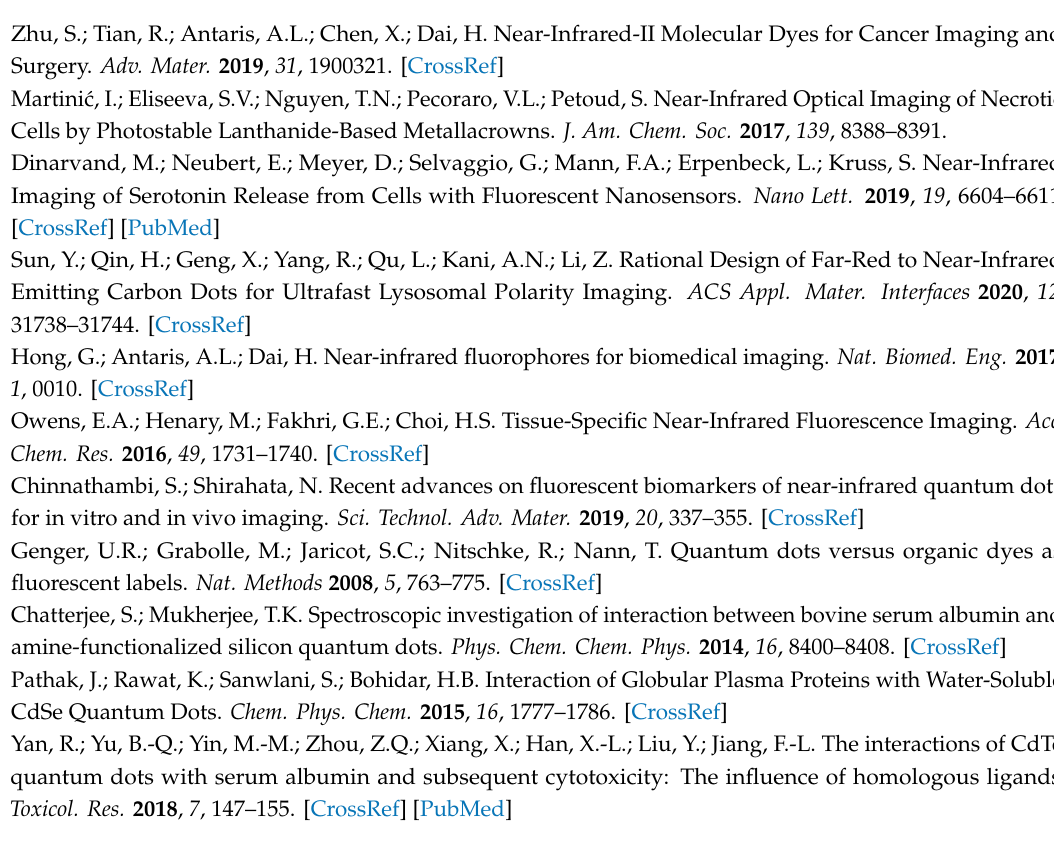
Figure S1: (a) A typical XRD spectrum of hydrogen-terminated SiQDs by HF etching for 85 min. (b) ATR-FTIR spectra of hydrogen-terminated SiQDs before and after hydrosilylation of 1-decence. Figure S2: Three di ff erent stages for preparing SiQD-De / F127 nanoparticles are demonstrated. Three pairs of photographs are taken under room illumination and UV light for each stage. Twenty-four microliters toluene of SiQD-De was poured into the glass bottle with 8 mL Milli-Q water. The amounts of toluene and water are indicated by arrows in a left-pair image. Figure S3: UV-visible absorption spectra, PL excitation (PLE) spectra, and PL spectra of four SiQD-De / F127 samples with di ff erent QD sizes. The diameters estimated from Scherrer broadening analysis are 4.8 nm, 3.4 nm, 2.9 nm, and 2.3 nm, respectively. Both PLE spectra centered at 328, 331, 352, 369 nm, and their corresponding PL spectra centered at 886, 800, 775, 720 nm spectrum are demonstrated for four SiQDs / F127 samples. Figure S4: AF4 fractogram with detection by DLS (red dots) of the nanoparticles in water. Figure S5: Typical results of cell viability after 24 and 48 h incubation with SiQD-De / F127 using (a) HeLa cells (b) A549 cells, and (c) NIH3T3 cells. Table S1: Binding parameters of SiQD-De / F127 nanoparticles during interaction with proteins. The Stern–Volmer constant (KSV), biomolecular quenching rate constant (kq), NPs lifetime ( τ 0 ), and the number of the binding site (n) for four classes of proteins interacted with the SiQD-De / F127 nanoparticles. R 2 shows a good fit with the Equation (1). Table S2: Changes in tryptophanyl fluorescence lifetime of the proteins by incremental addition of the SiQD-De / F127 nanoparticles. Table S3: Changes in PL lifetime of SiQD-De / F127 nanoparticles by the gradual addition of the proteins. Table S4: Secondary structural analysis of albumin during interaction with SiQD-De / F127 nanoparticles. Table S5: Secondary structural analysis of fibrinogen during interaction with SiQD-De / F127 nanoparticles. Table S6: Secondary structural analysis of transferrin during interaction with SiQD-De / F127